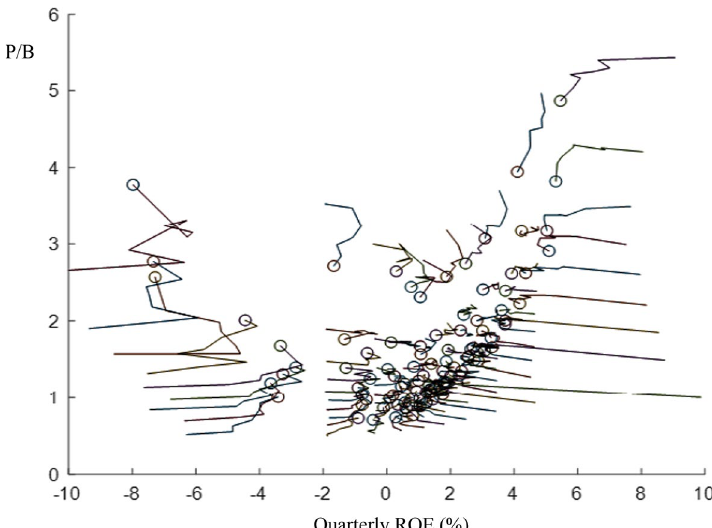
Fig. 7 The ROE and P/B ratio for the current quarter and the subsequent eight quarters after the portfolios being